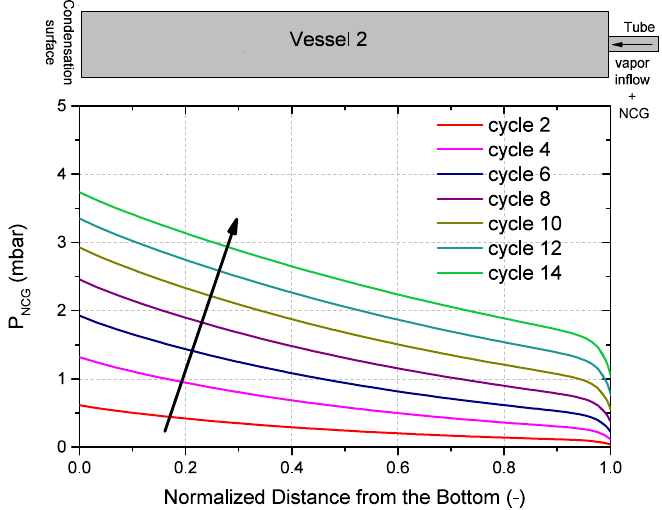
Figure 14. Pressure along with the central axis of vessel 2 at the half-time point of each cycle, that is, the condensation period for vessel 2. The point where the normalized distance equals 1 represents the connection of tube and